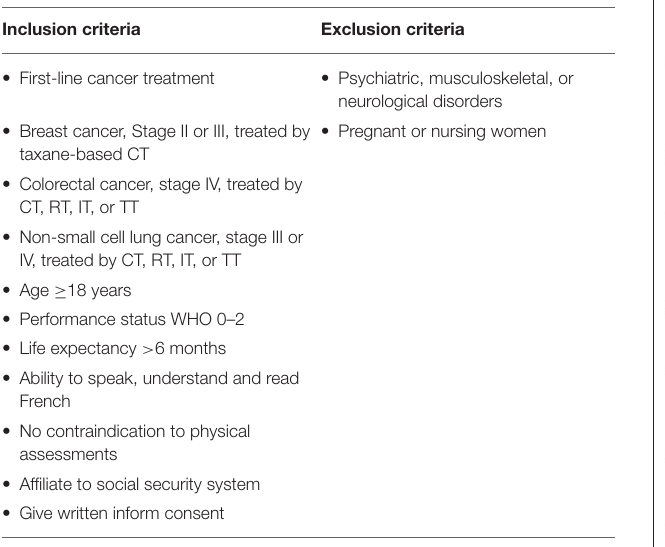
FIGURE 2 | Flowchart of the PROTECT-01 study